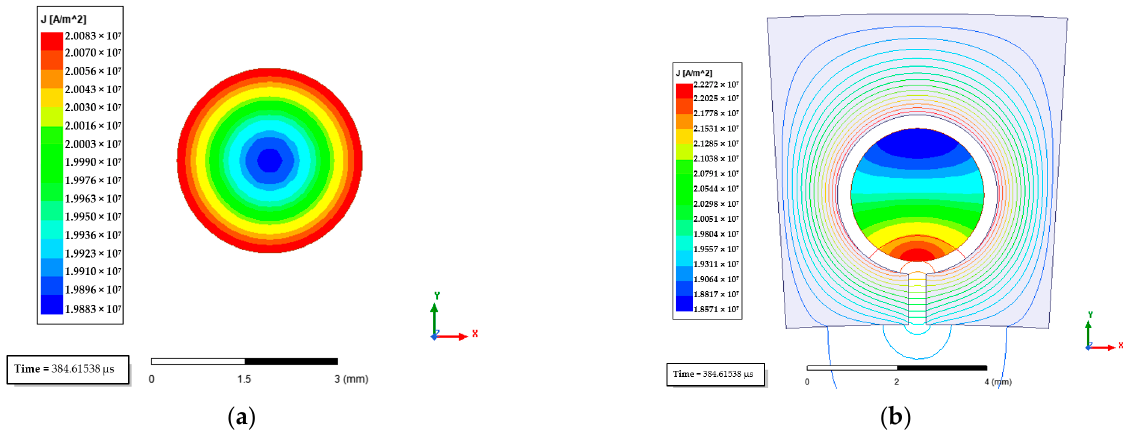
Figure 12. Current distribution in a circular bar excited with a sine current f = 650 Hz. ( a ) bar in air ( b ) bar surrounded by a magnetic.